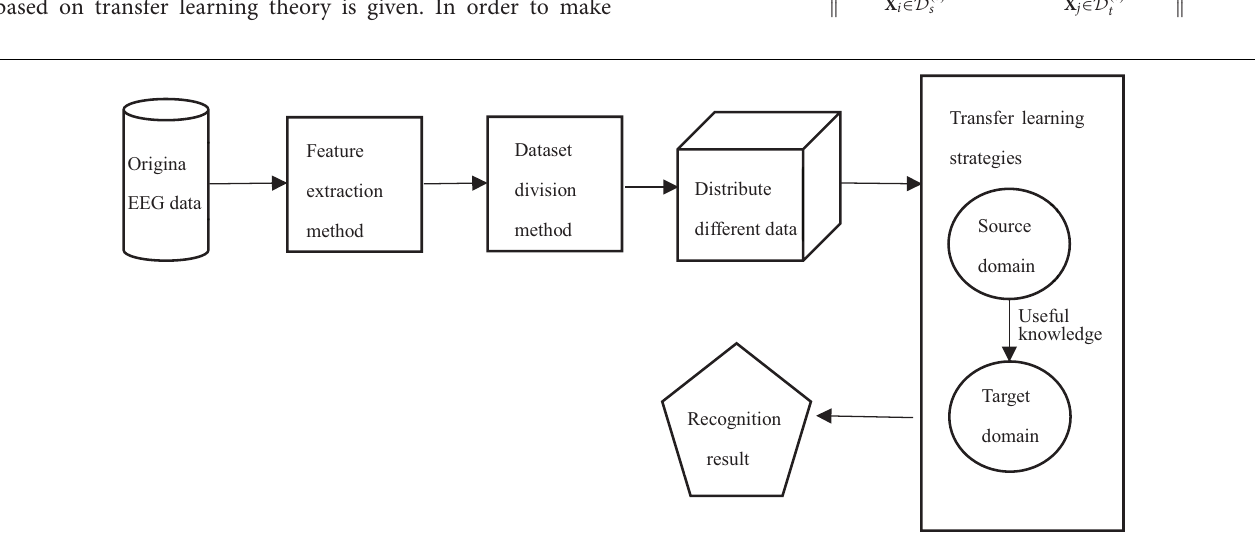
FIGURE 5 | Framework of EEG signal recognition based on transfer